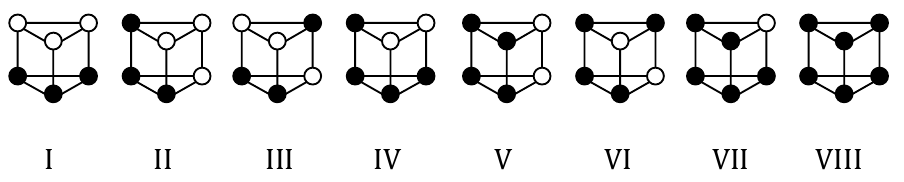
Figure 1: The eight category structures from Seinhorst (2016a,